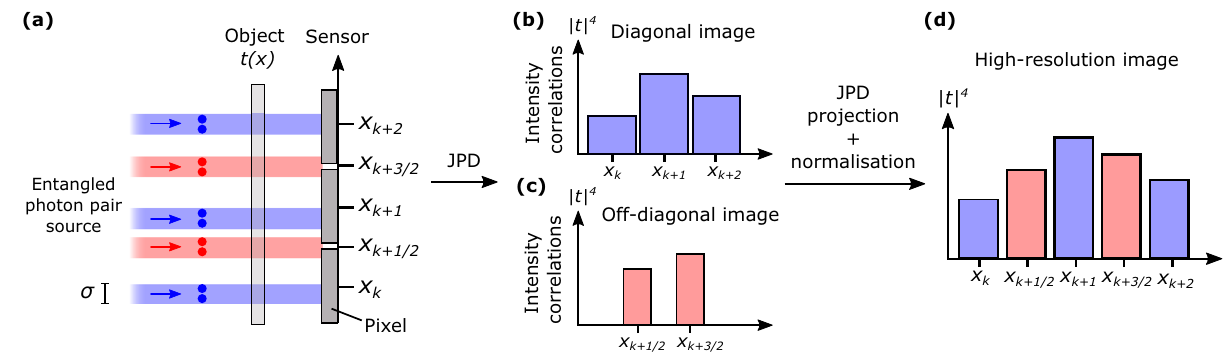
Fig. 2 Principle of JPD pixel super-resolution. a Schematic of the optical imaging system composed of an object t illuminated by entangled photon pairs with correlation width σ and imaged onto an array of pixels. Δ and δ are pixel pitch and gap, respectively. Positions at the center of pixels are noted using an integer indices i.e. x k , while those between pixels are noted using half-integer indices i.e. x k + 1/2 . Blue rays represent some photon pairs falling on a single pixel and red rays some falling on two nearest-neighbor pixels. b , c Unidimensional images formed by JPD diagonal elements Γ kk and off-diagonal elements Γ kk + 1 , respectively. d Performing a sum-coordinate projection of the JPD using equation (1) recombines these two low-resolution images into a high- resolution dimensional object t ( x ) imaged onto an array of pixels with pitch Δ and pixel gap δ (i.e. the width of non-active areas between